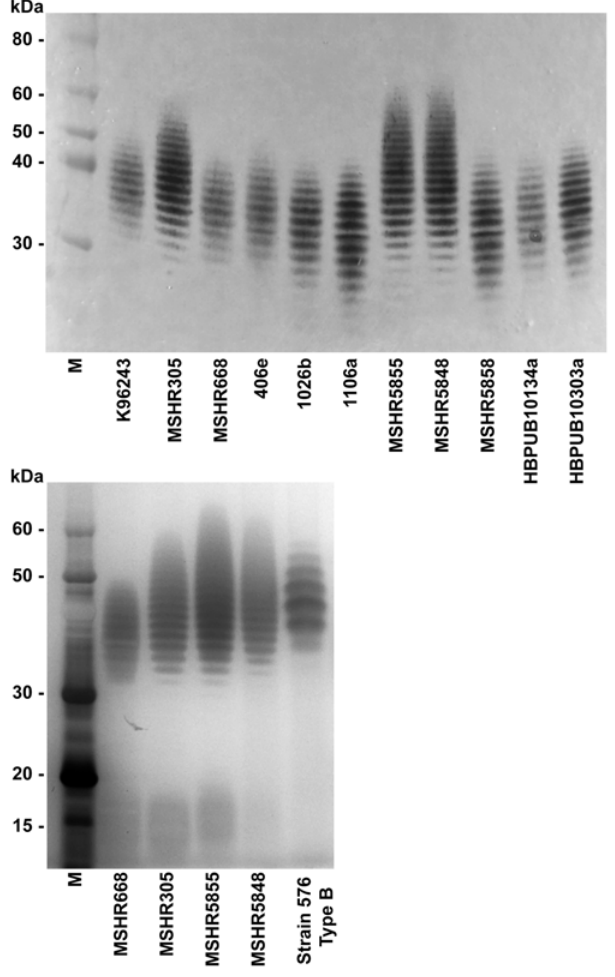
Fig 1. B . pseudomallei LPS profiles. A. Purified LPS samples from 11 B . pseudomallei strains were separated by SDS-PAGE. The gel was electroblotted, and the western blot was developed using a monoclonal antibody directed against B . pseudomallei LPS (11G3-1). B. Results were confirmed by silver staining. B . pseudomallei 576 displaying the LPS type B banding pattern is shown for comparison. M = molecular weight